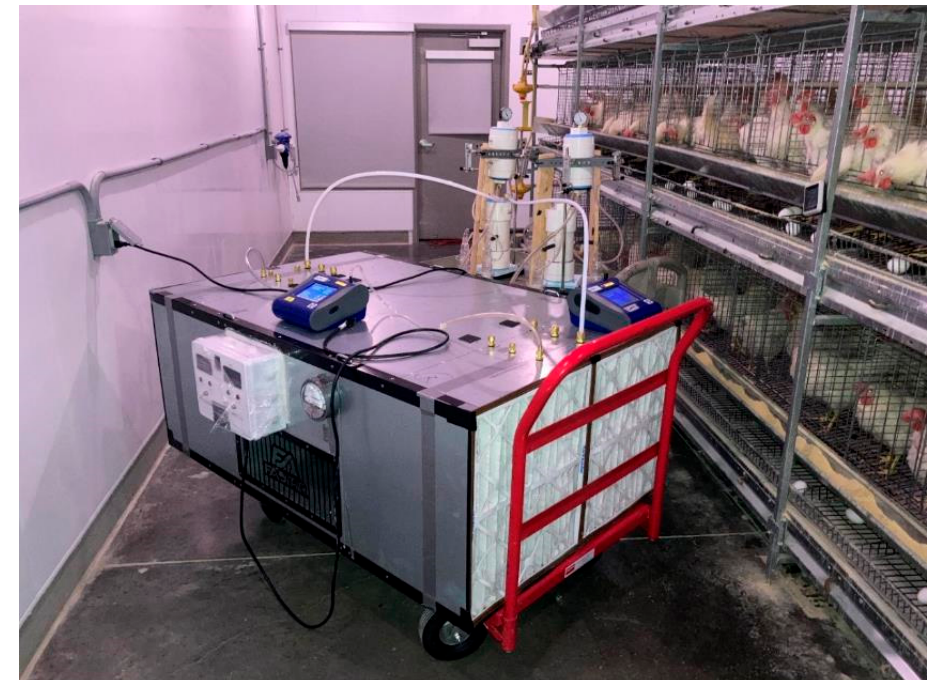
Figure 6. The experimental setup for collecting viable airborne bacteria and PM at a teaching room that housed ~150 laying hens at ISU Poultry Teaching and Research Facility. The red cart was used to deploy the FastAir prototype into the testing room. The brown cart (behind) held all sampling equipment (vacuum pumps, manifolds, and BioSamplers ® ).